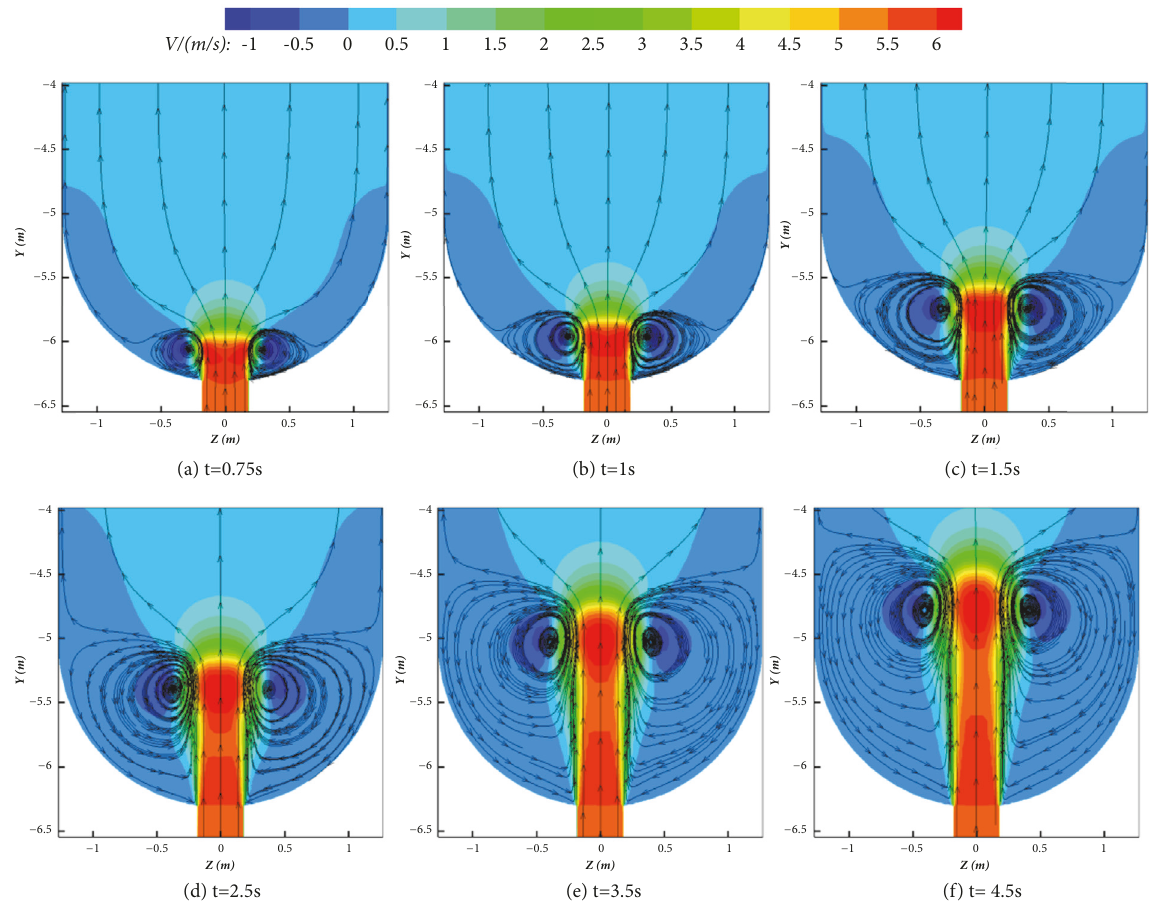
Figure 14: The distribution of transient velocity flow field in the center